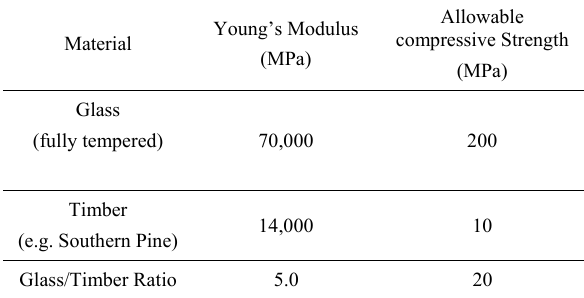
Table 1: An Timber vs Glass as a compression